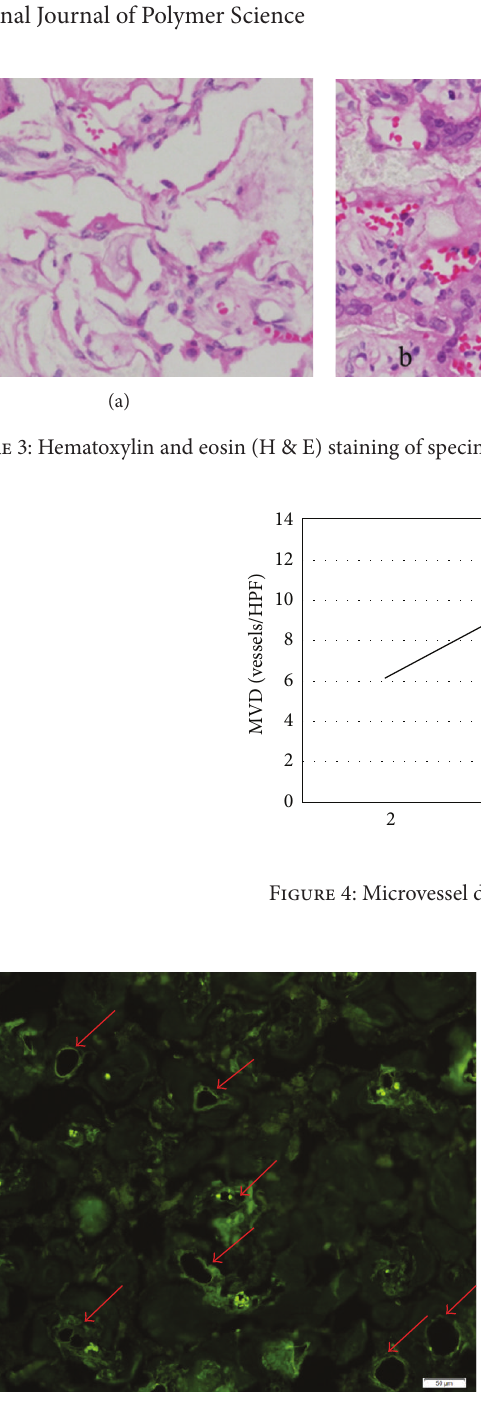
Figure 5: CD31 immunofluorescence histochemical staining of specimens by 10 weeks after implantation (magnification × 200): the vascular walls and red blood cells display remarkable light green